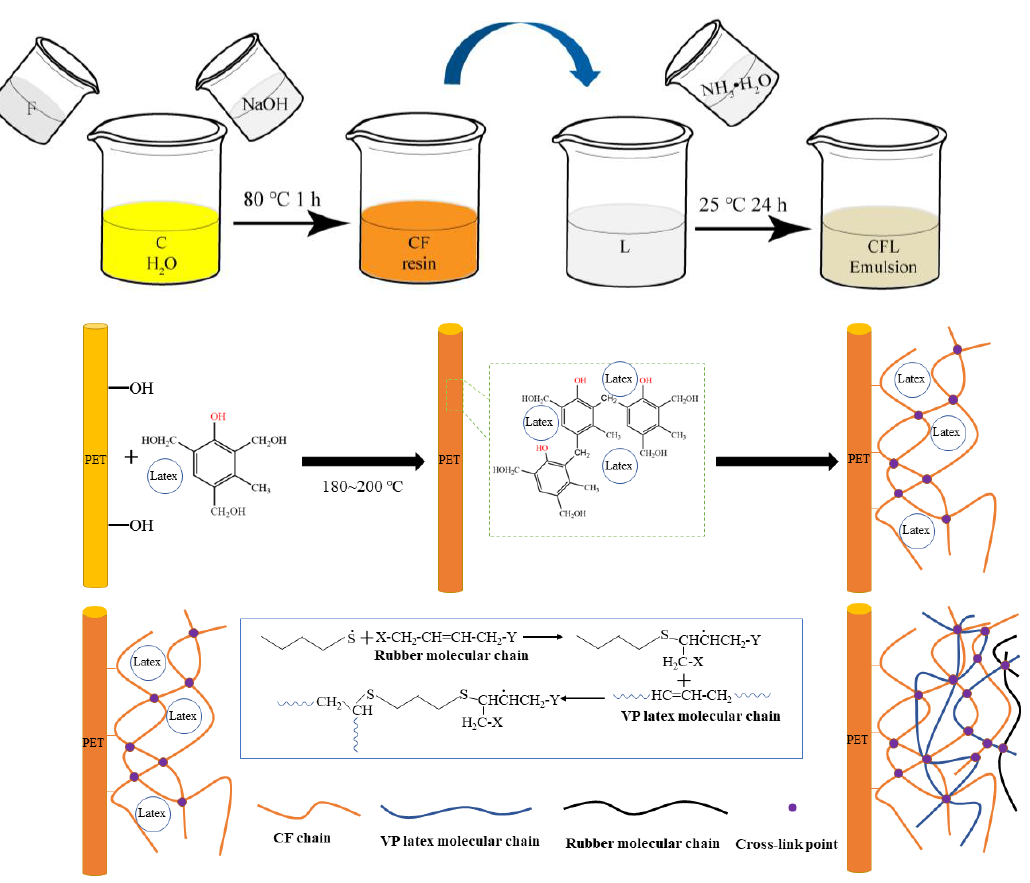
Figure 2. The preparation process of different CFL emulsions and the fiber